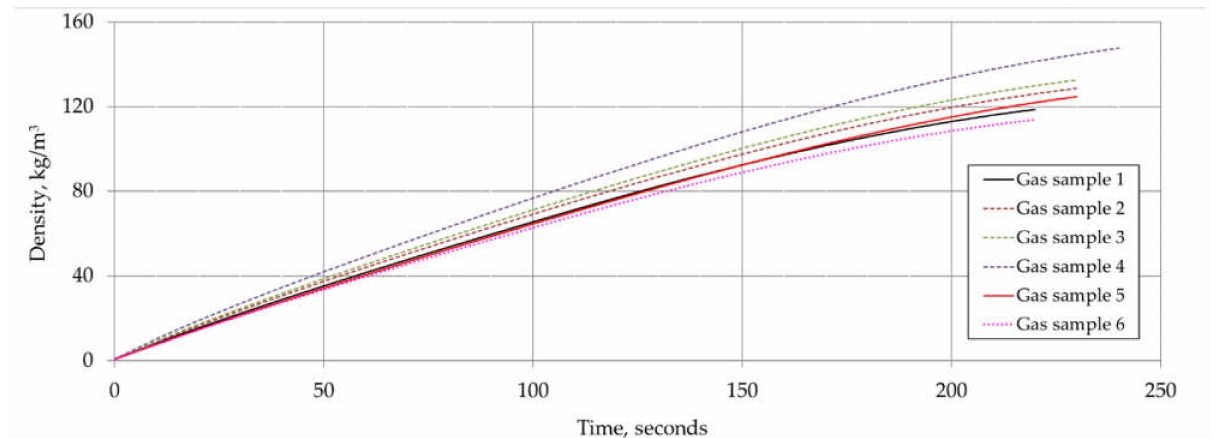
Figure 8. Density profiles for the considered natural gas mixtures during the fast filling process of the composite tank (type